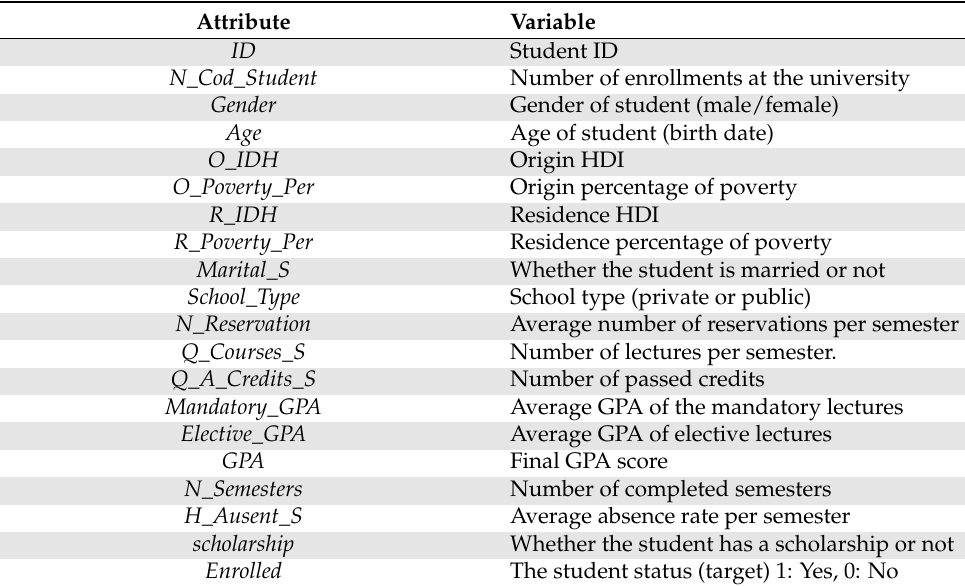
Figure 2. Correlation matrix for variables presented in Table 1. Table 1. Description of the data attributes collected from every student at the studied